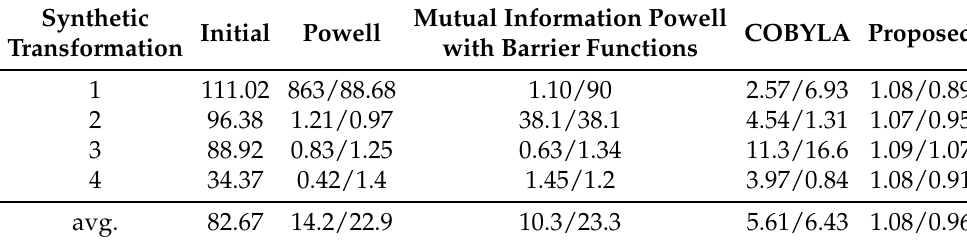
Figure 7. Input image pairs and domain adaptation results from the Brazil dataset. The RMSE obtained by the proposed method and the previous approaches is presented in Table 3. Table 3. RMSE in pixels for the Brazil dataset (area 1/ area2) and four test transformations.